Question: Express in one sentence what the figure is showing.
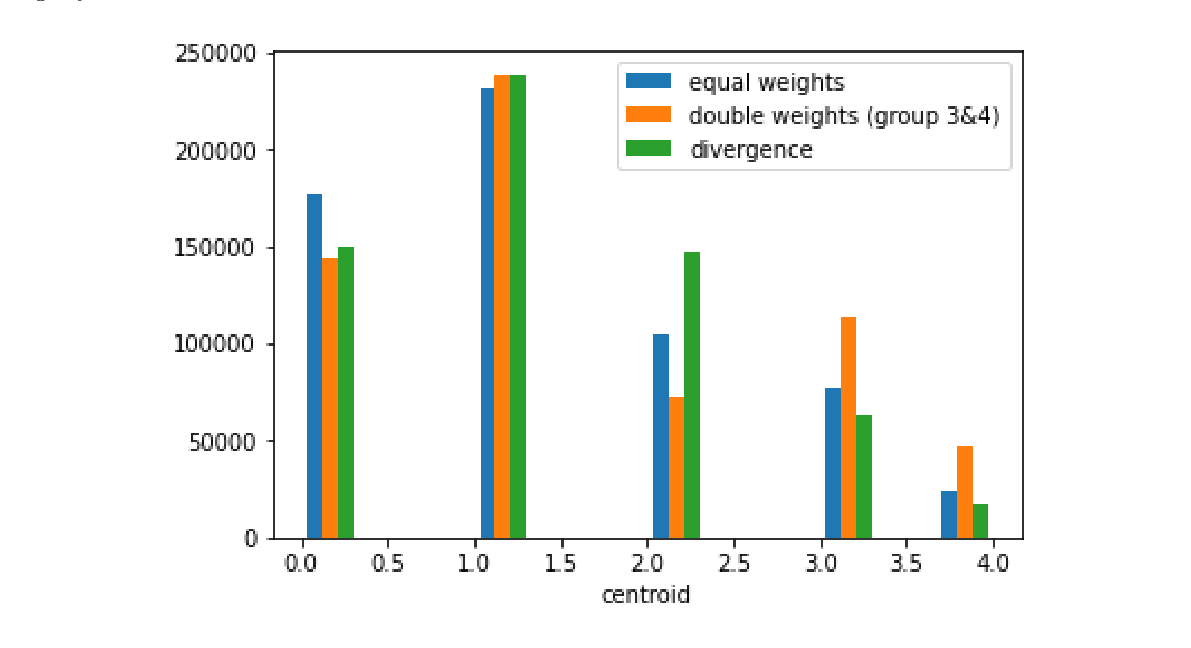
Answer: Distributions of prediction centroids on DR data